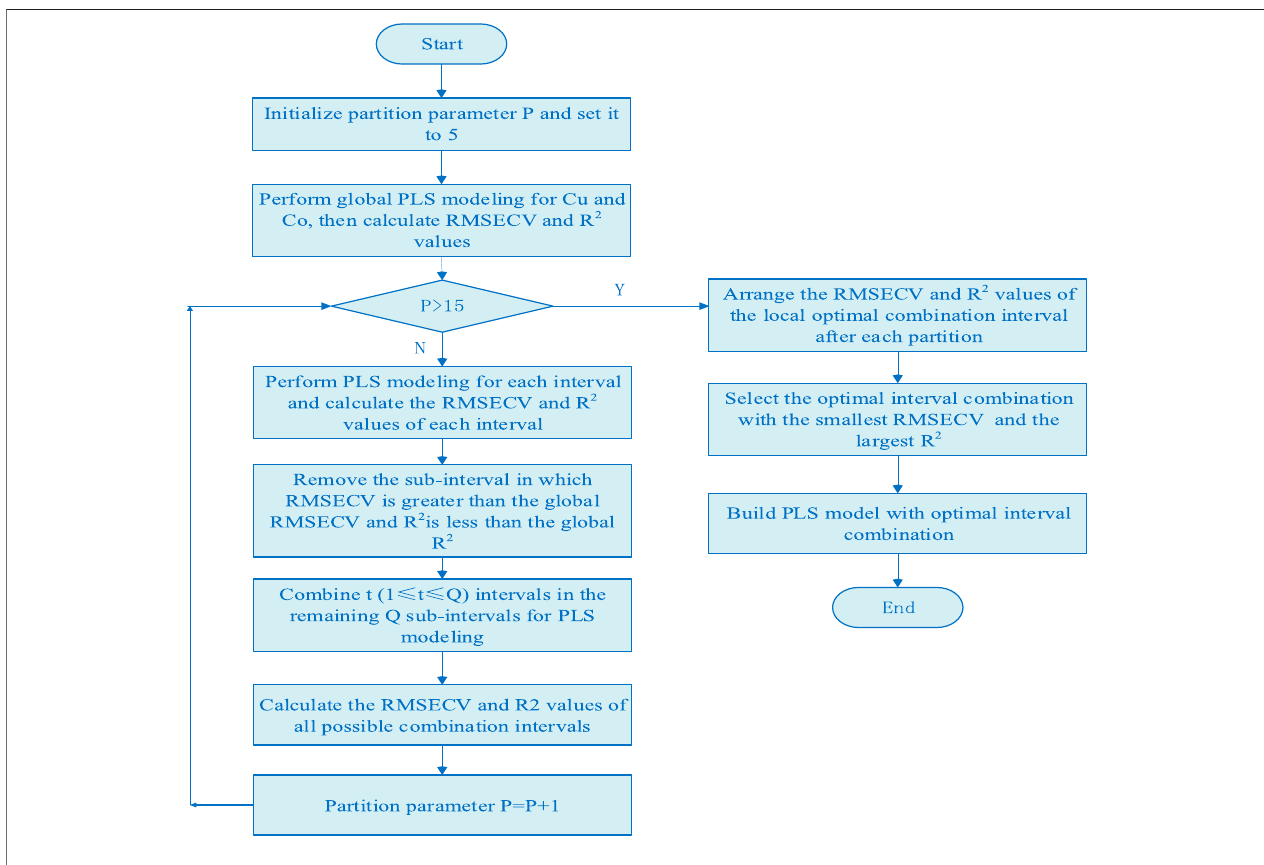
FIGURE 1 | The fl ow chart of characteristic interval modeling method.